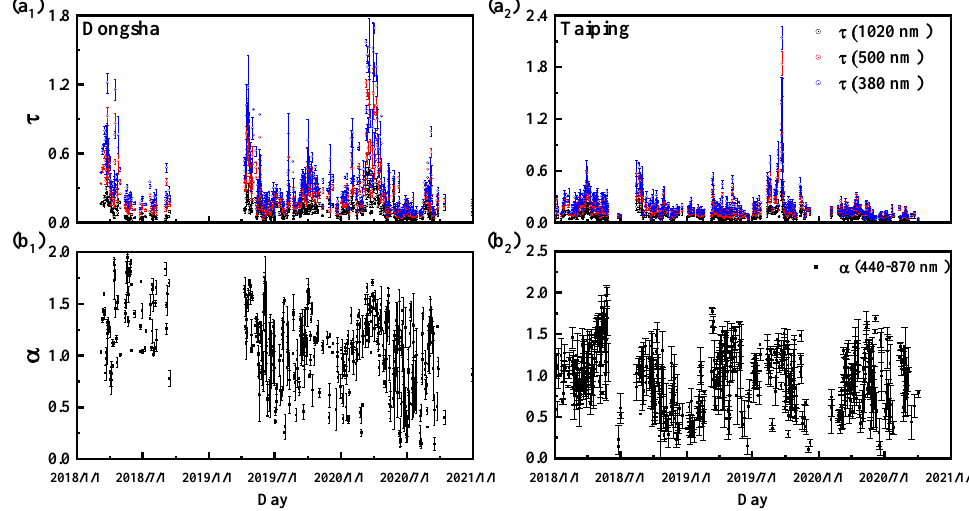
Figure 3. ( a ) Daily average aerosol optical depth at 380, 500 and 1020 nm and ( b ) Ångström index calculated from 440 to 870 nm at Dongsha Island ( a 1 , b 1 ) and Taiping Island ( a 2 , b 2 ) in the South China Sea from 1 January 2018 to 31 December 2020. The error bars are the standard deviations. Table 1. Multi-wavelength (1020, 500 and 380 nm) aerosol optical depth τ , Ångström exponent ( α (440–870)), fine aerosol optical depths at 500 nm ( τ F (500 nm), coarse aerosol optical depths at τ C (500 nm)) and fraction of optical depth of fine mode particles (FMF) in Dongsha from 1 January 2018 to 31 December 2020. All data were processed using daily averages. The total number of samples (N total), average coefficient (Mean), standard deviation (SD), Minimum (Min), Median (Med), Maximum (Max) and the coefficient of fluctuation (FOC) are also counted to assess variations in the